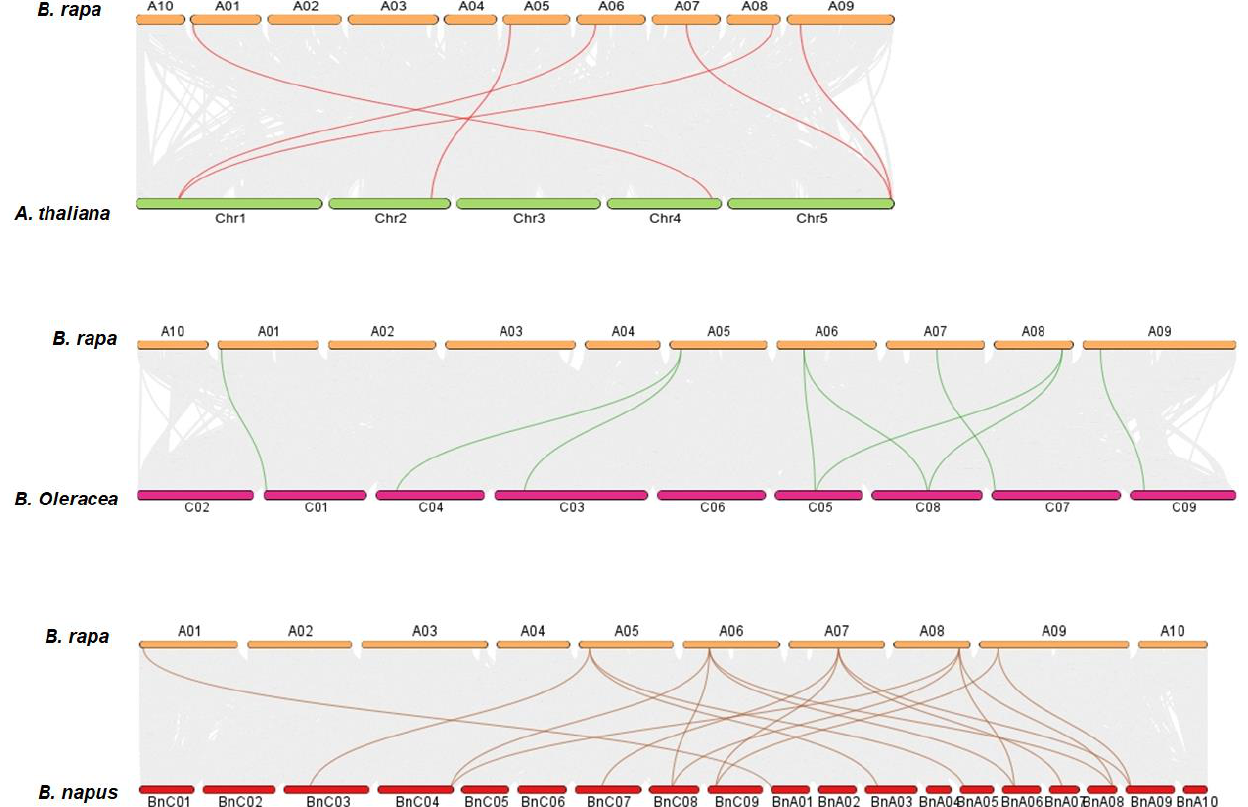
Figure 3. Synteny analysis of DA1 & DARs between B. rapa , A. thaliana , B. oleracea , and B. napus . Gray lines show the syntenic pairing between B. rapa , A. thaliana , B. oleracea , and B. napus genomes, while colored lines represent the syntenic association.